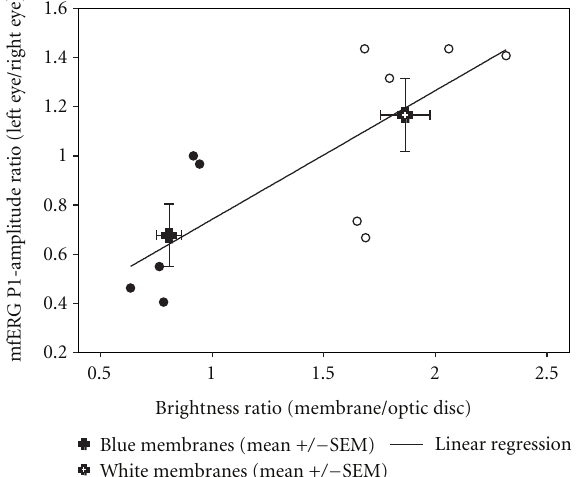
Figure 5: Mean values of white and blue membranes and cor- relation between brightness ratio (membrane/optic disc) and P1- amplitude ratio (left/right). Large symbols represent mean ± SEM for white and blue membranes and show a significant di ff erence in P1-amplitude ratio ( P = 0 . 027) and brightness ratio ( P < 0 . 001). When observed together, the blue ( • ) and white ( ◦ ) membranes show a significant correlation ( r = 0 . 762; P = 0 .